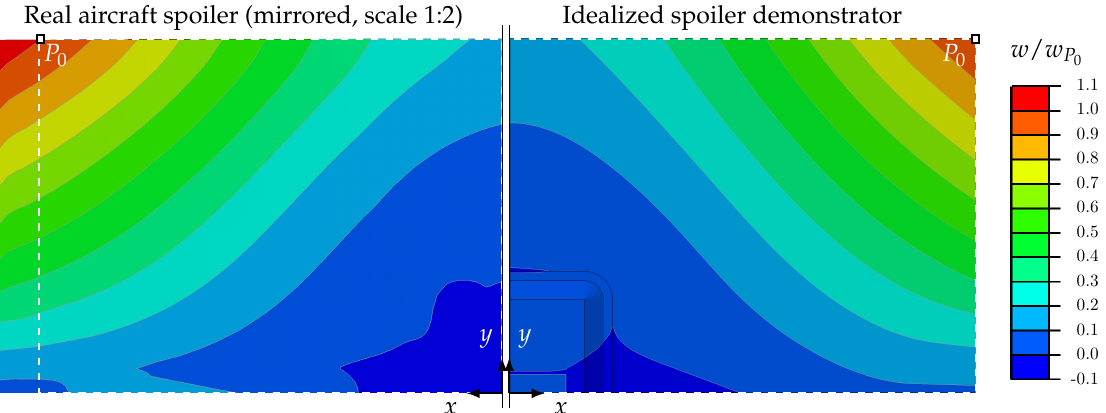
Figure 7. Out-of-plane displacement contour plots of numerical FE models (dashed rectangles indicate the size of the idealized spoiler